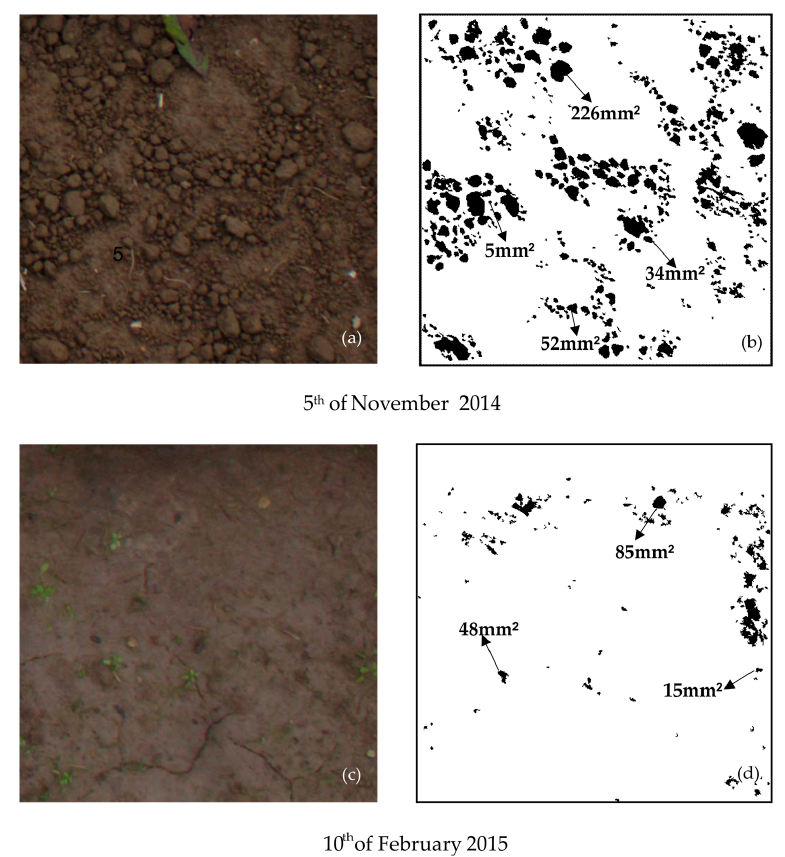
Figure 3. On the left side are original images ( a , c ) of Soil 1. Using the Huang thresholding technique, soil aggregates (black color) on the right side ( b , d ) are defined. While images ( a , b ) show the results at the beginning of the experiment (5 November), images ( c , d ) show the results at end of the experiment (10 February). The area of some aggregates calculated in mm 2 is shown as an example.